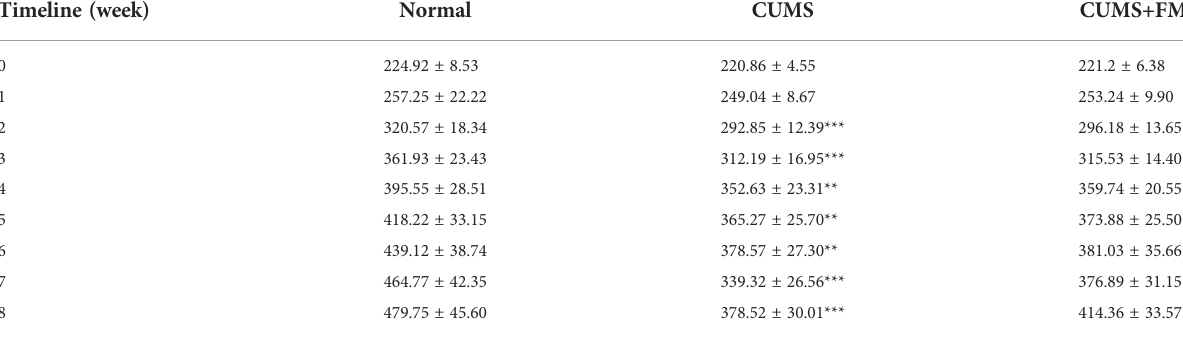
TABLE 1 Weight comparisons at different time points in each group. Timeline